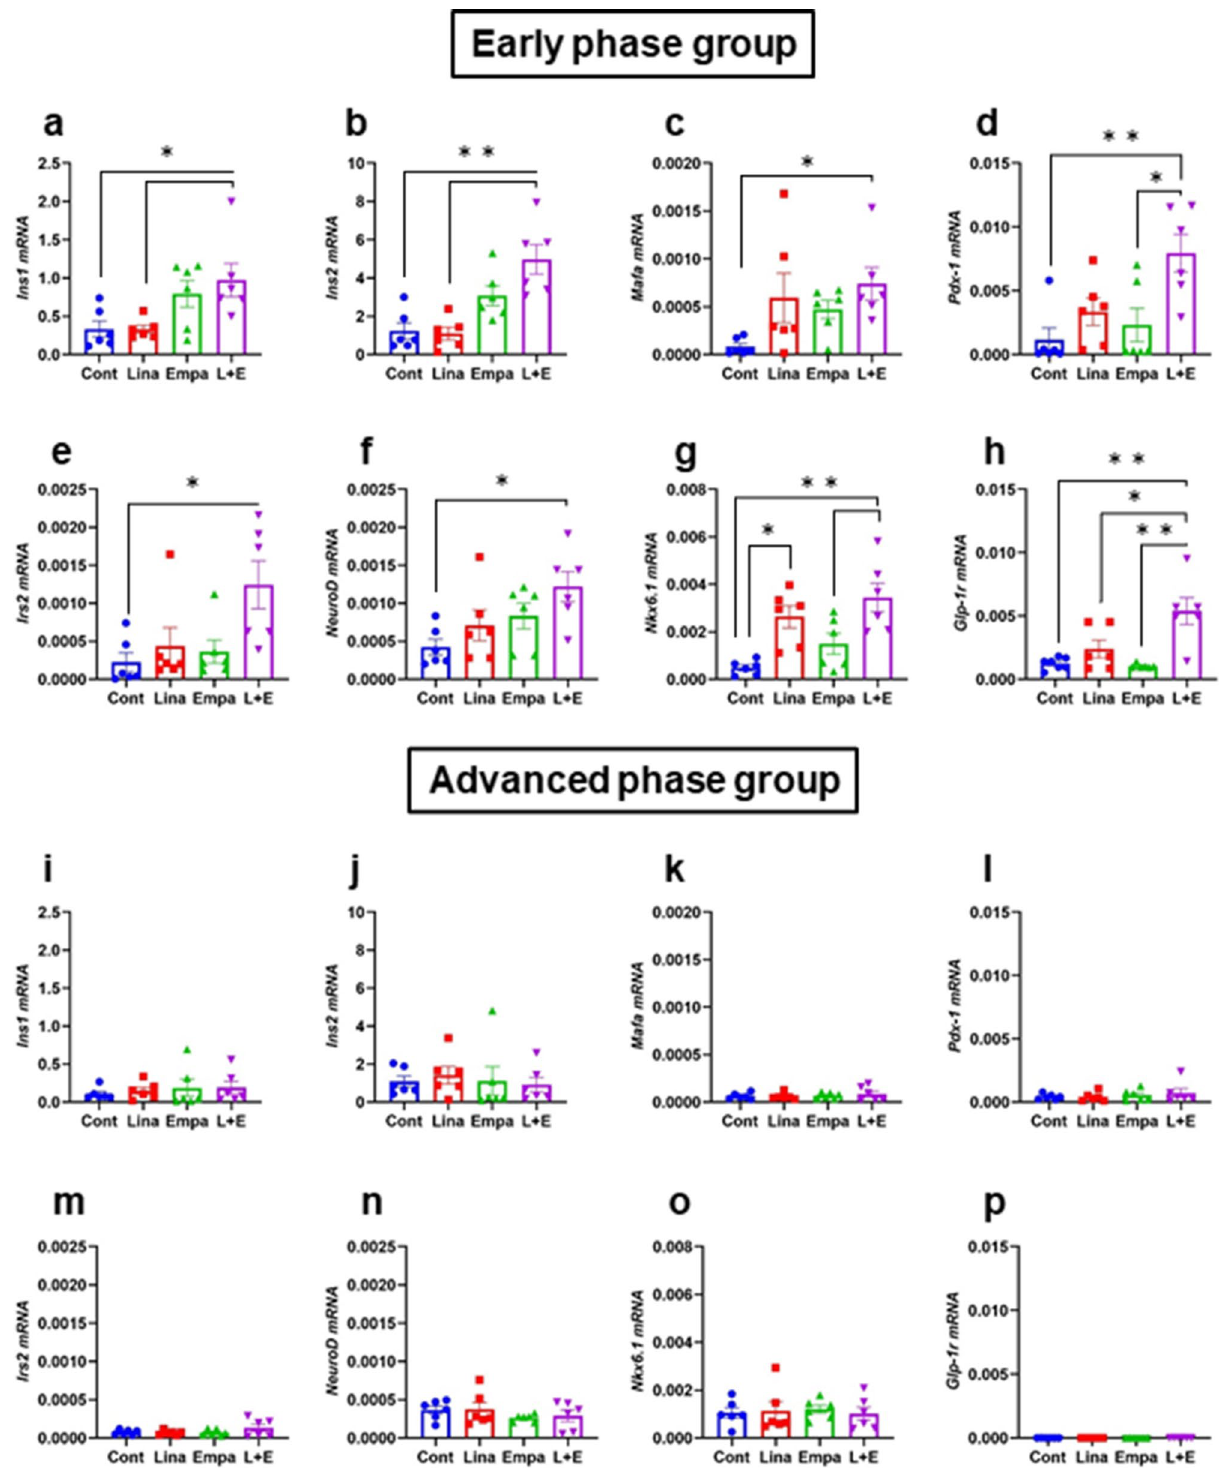
Figure 6. Expression levels of insulin and insulin gene transcription and GLP-1 receptor in ( a – h ) an early phase and ( i – p ) an advanced phase of diabetes. ( a , i ) Insulin1 , ( b , j ) Insulin2 , ( c , k ) MafA , ( d , l ) Pdx-1 , ( e , m ) Irs2 , ( f , n ) NeuroD , ( g , o ) Nkx6.1 , ( h , p ) Glp-1r (n = 6). The multiple comparison was performed using the Tukey– Kramer method. Data are presented as mean ± S.D. *: p <